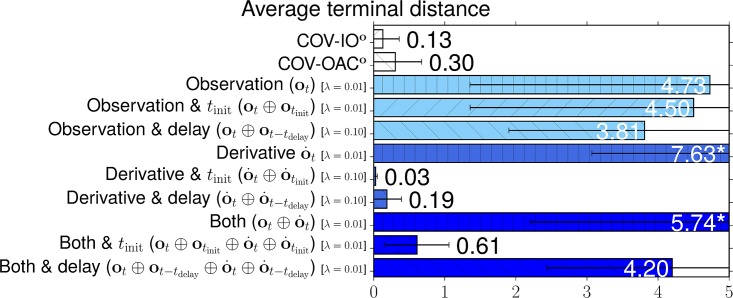
Average terminal distance when learning policies on different types of observations.Values annotated by a star indicate that the corresponding bar exceeds the bounds of the figure.